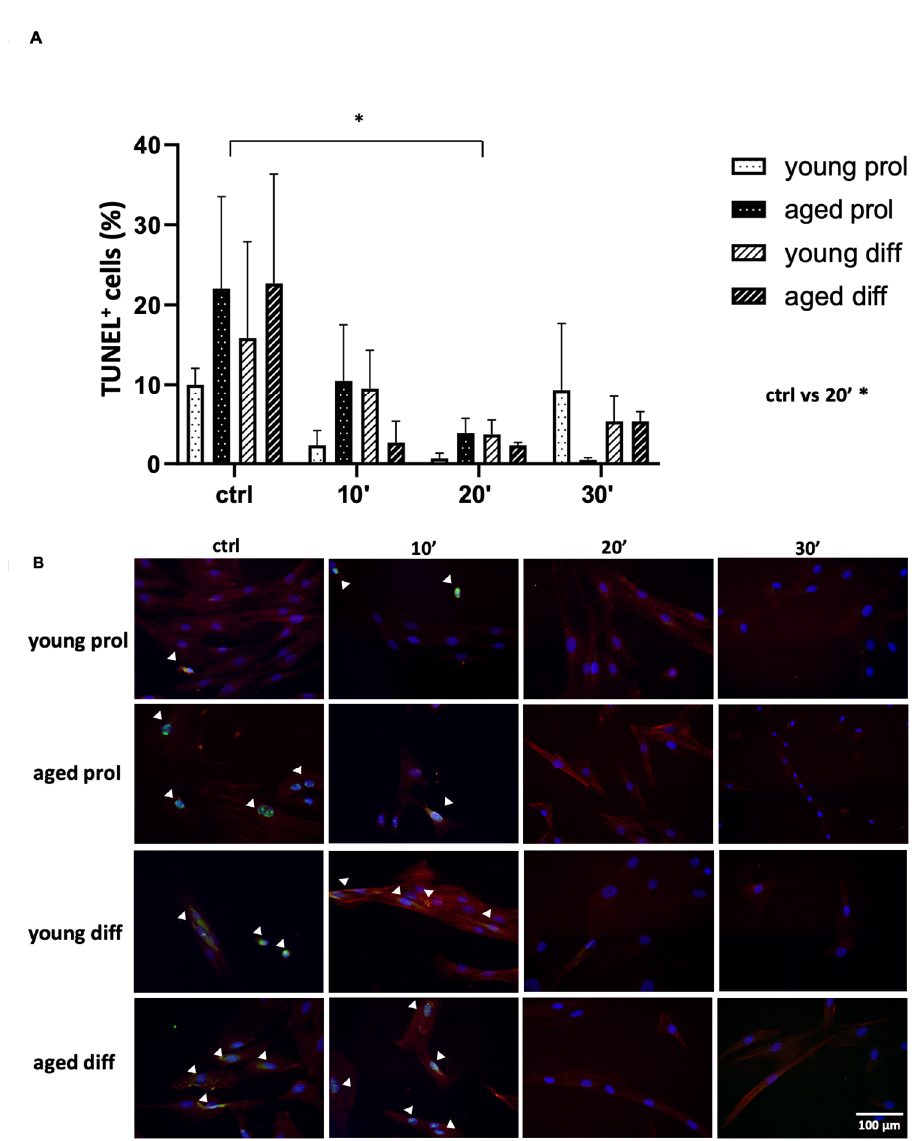
Figure 1. Effect of ViSS treatment on SC/myoblast apoptosis and actin cytoskeleton. ( A ) Data are expressed as mean ± SEM of three independent experiments ( n = 3); apoptotic cells were scored out of a total of 70–130 cells for each experimental group; significance was determined with two-way ANOVA test, followed by Tukey’s multiple comparisons test (main row effect). * p ≤ 0.05. ( B ) Representative fields of TUNEL (green labeling) and β -actin (red labeling) doubled-stained SCs, counterstained with DAPI (blue labeling); white arrows point at apoptotic cells.